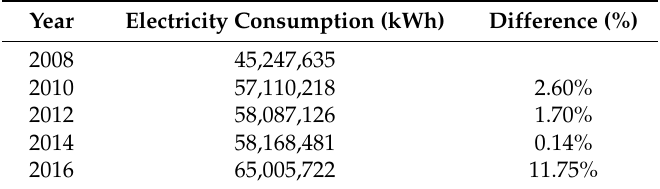
Table 4. Port of Valencia electricity consumption between 2008 and 2016. Source: Valencia Port